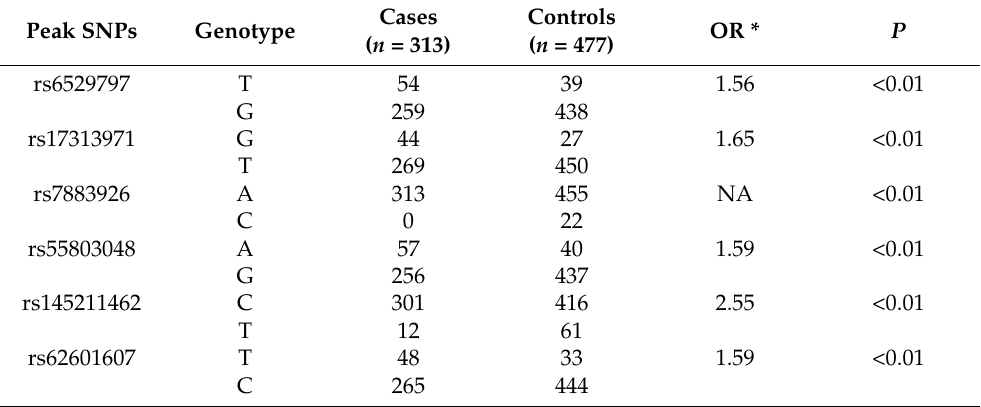
Table 2. Genotype of peak SNPs in